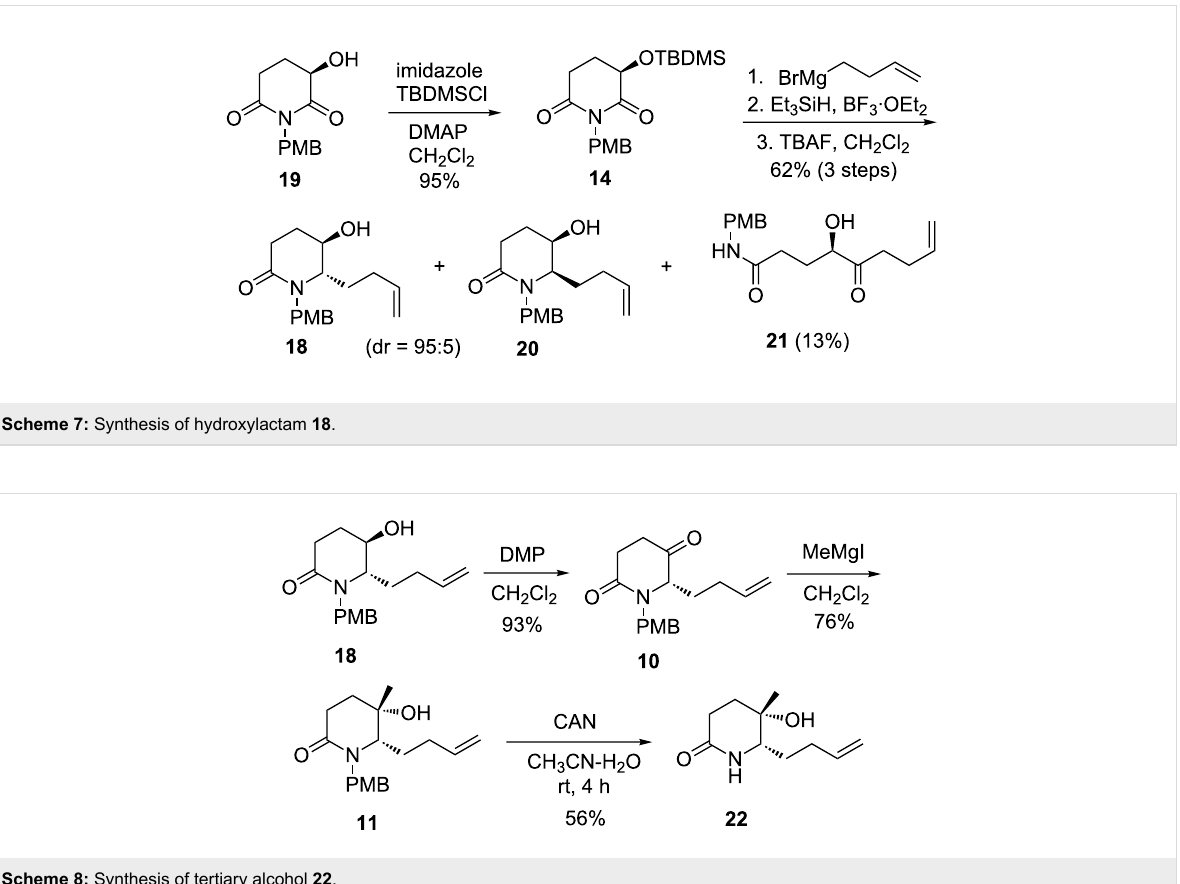
(v/v 3:1) [50] at room temperature for 4 h to afford the